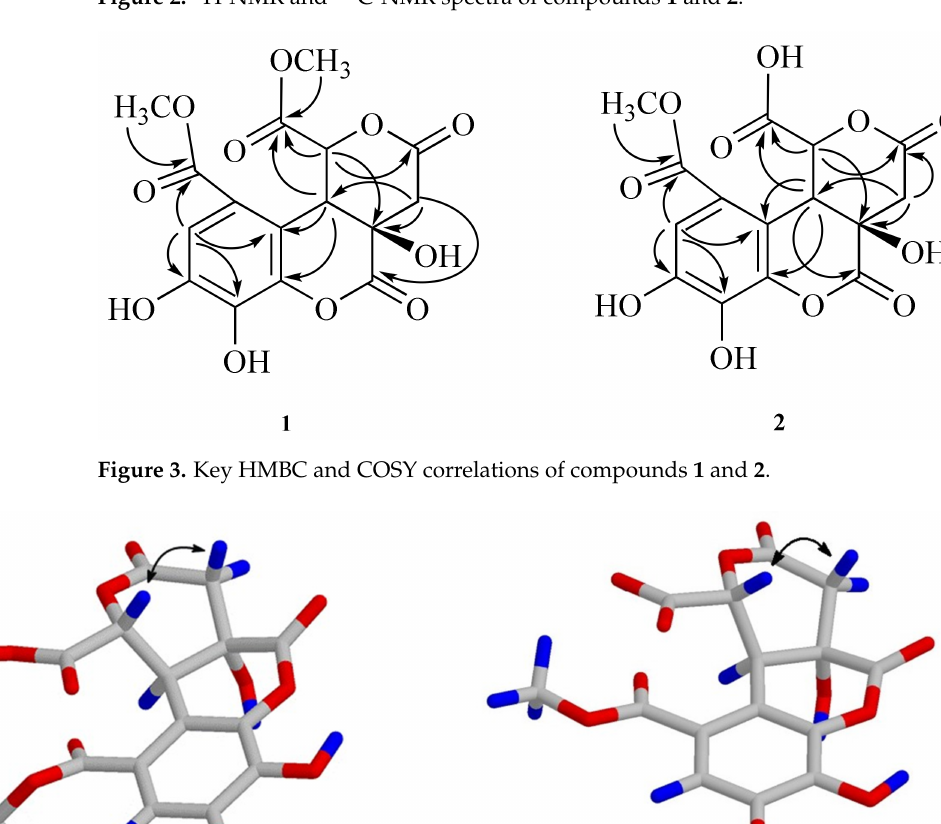
Figure 2. 1 H-NMR and 13 C-NMR spectra of compounds 1 and 2 .